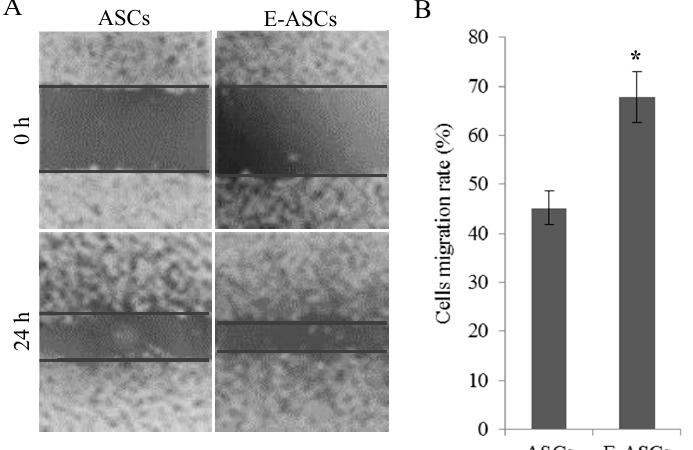
Figure 2. Effect of eugenol on migration ability of ASCs in vitro. ( A ) Representative photos at 0 and 24 h after incubating the cells with normal medium (ASCs) or eugenol-containing medium (E-ASCs). ( B ) Migration ability of the cells. Bars represent mean ± SD. Significant difference is analyzed by a Student’s t -test, where: *: p < 0.01. ASCs: adipose tissue-derived mesenchymal stem-like cells, E-ASCs: adipose tissue-derived mesenchymal stem-like cells treated with eugenol for 24 h.